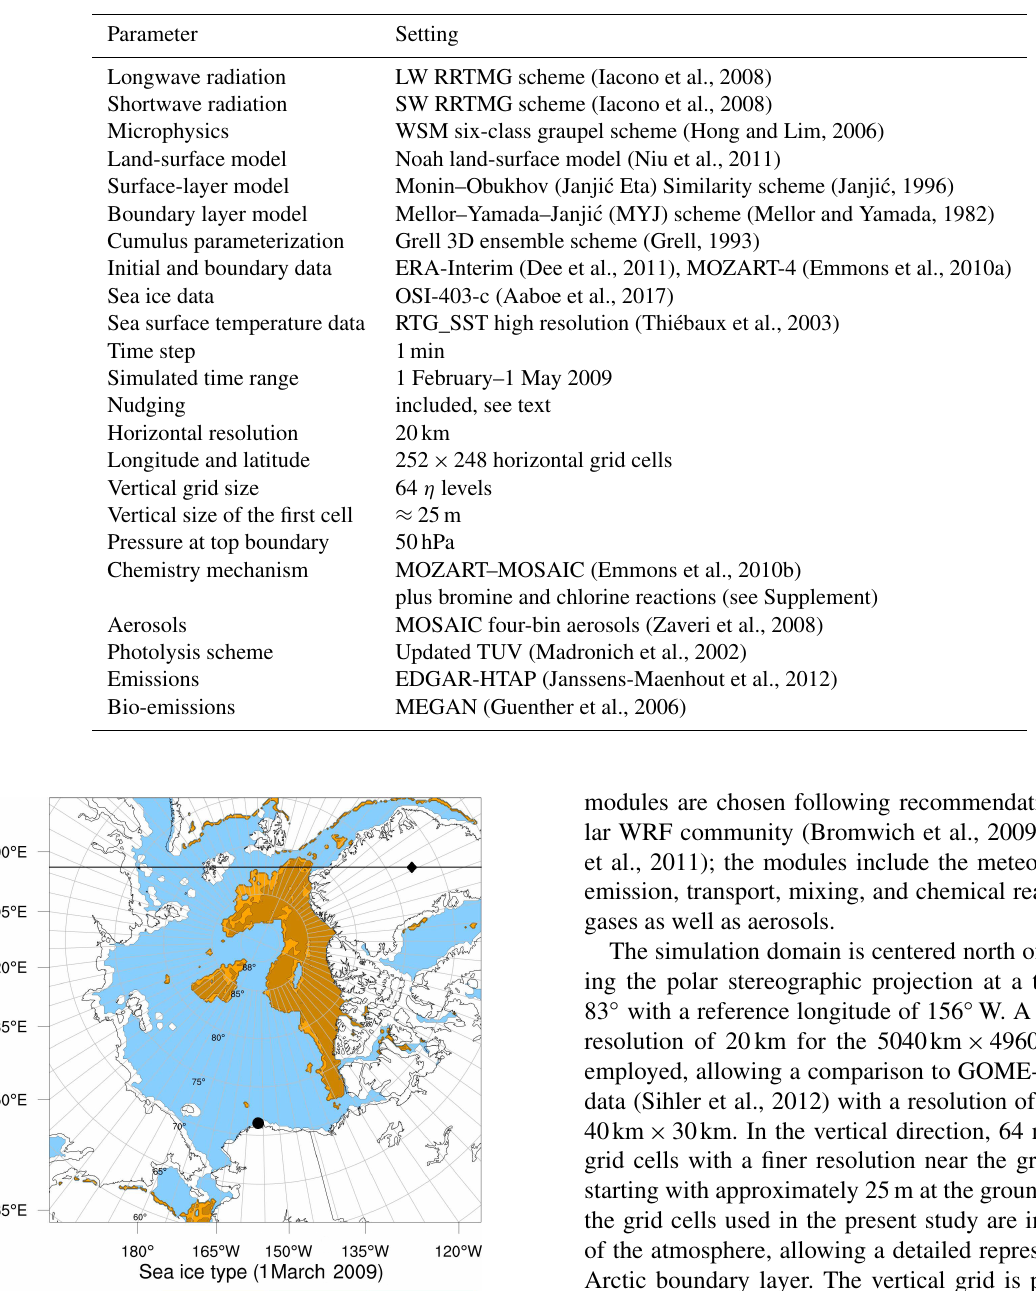
Table 1. Summary of the configuration of WRF-Chem. RRTMG refers to the Rapid Radiative Transfer Model for GCMs (global circulation models), LW stands for longwave, SW stands for shortwave, WSM denotes WRF Single Moment, TUV stands for Tropospheric Ultraviolet and Visible, EDGAR-HTAP stands for Emissions Database for Global Atmospheric Research – Hemispheric Transport of Air Pollution, and MEGAN stands for Model of Emissions of Gases and Aerosols from Nature.